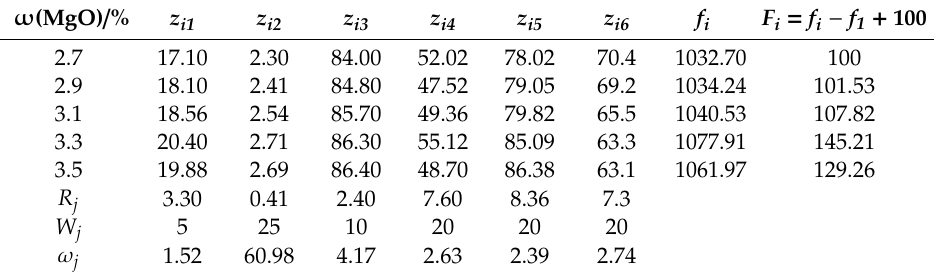
Table 6. Calculation process of comprehensive